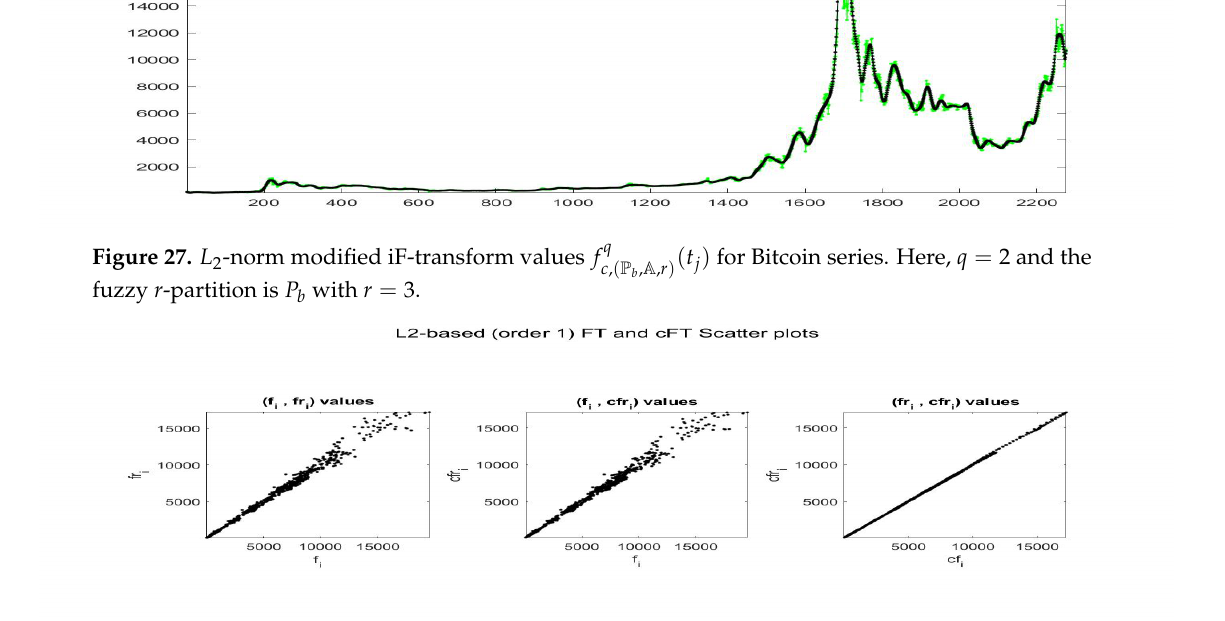
Figure 28. Pairwise scatter-plots of values f j , f q smoothing of order q = 1 for Bitcoin series. The fuzzy r -partition is P b with r = 3.